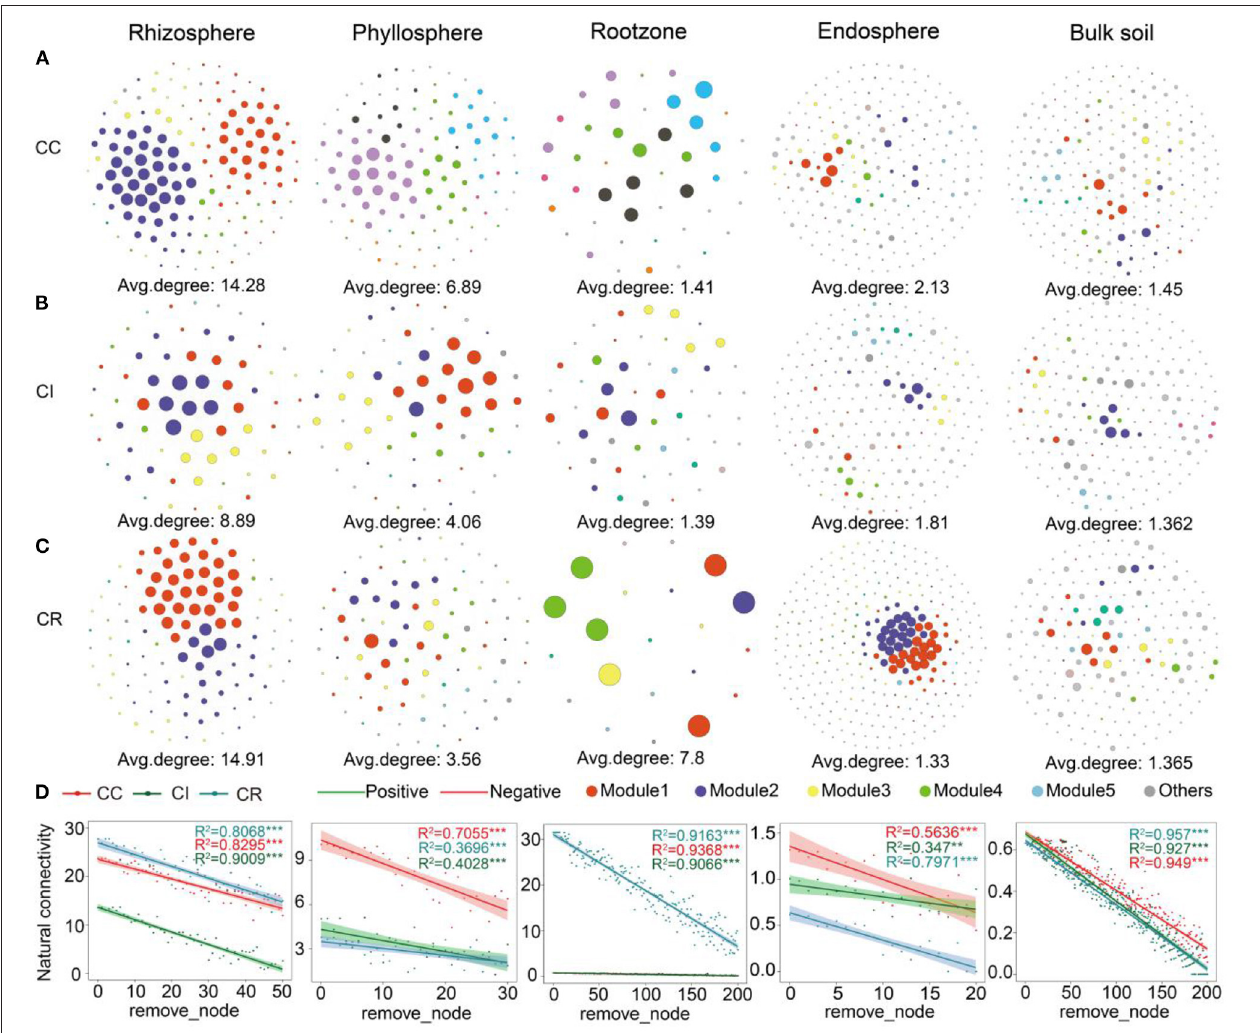
FIGURE 3 | Bacterial co-occurrence networks in different soil-plant continuums compartments under (A) continuous cropping (CC), (B) intercropping (CI), and (C) crop rotation (CR) systems ( n = 300). (D) Natural connectivity of microbial networks in different compartments of three cropping systems.